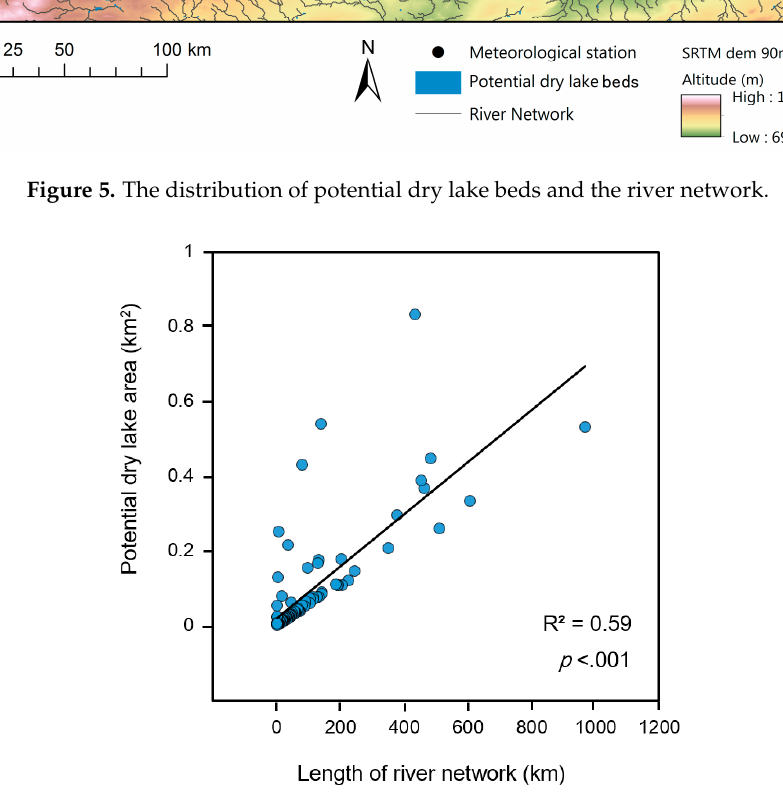
Figure 6. Correlation between potential dry lake bed areas and the length of the river network.